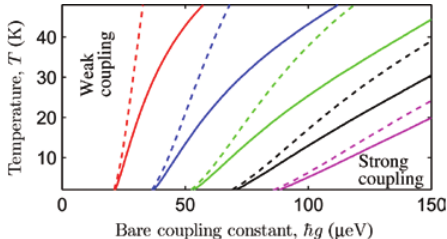
Figure 13: Parameter space where strong coupling and weak coupling resides for QD-based cQED depending on the bare coupling constant and the temperature. affects strongly the transition from weak to strong coupling (solid lines with renormalization, dashed lines without). Reprinted figure with permission from [163]. © 2010 by the American Physical